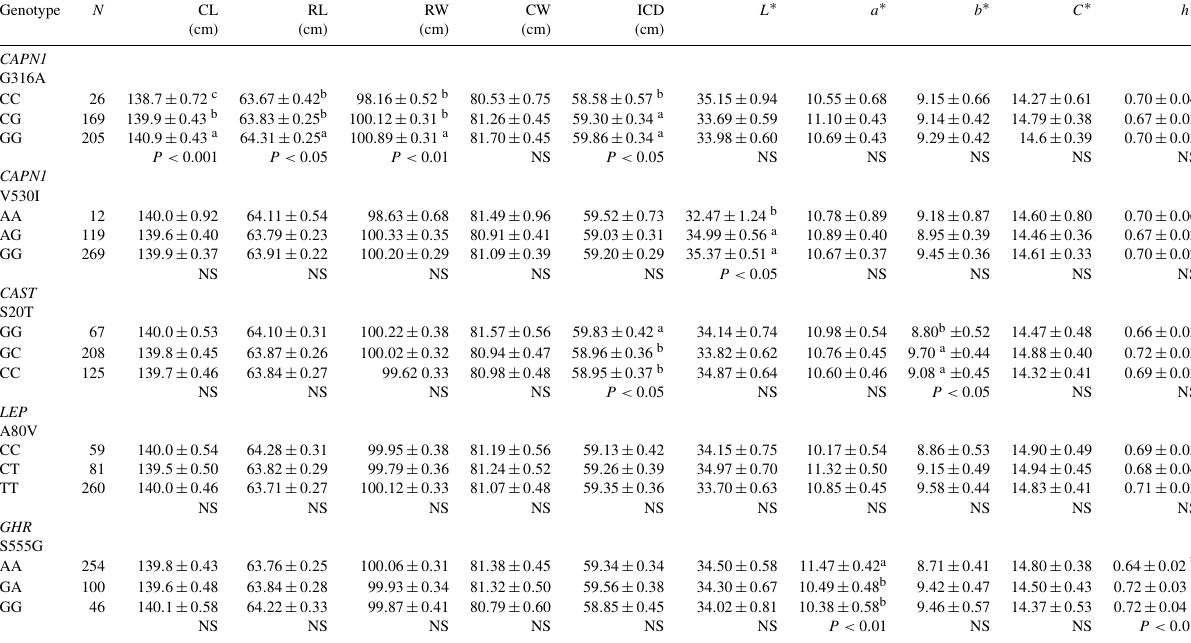
Table 4. Levels of significance, least-squares means, and standard errors for the effect of CAPN1 , CAST , LEP and GHR on carcass measure- ment and meat colour in a Holstein